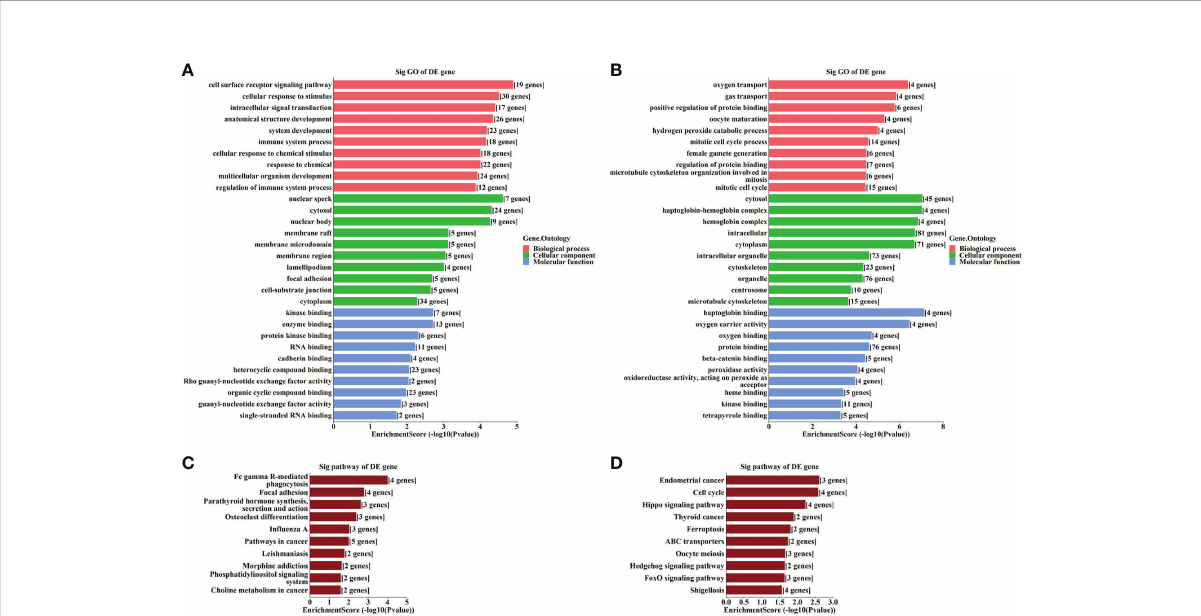
FIGURE 2 GO and KEGG analyses according to the host genes of the signi fi cantly altered circRNAs. (A) Top gene ontology (GO) terms with the host genes of the up-regulated circRNAs. (B) Top GO terms with the host genes of the down-regulated circRNAs. (C) Top Kyoto Encyclopedia of Genes and Genomes (KEGG) pathways with the host genes of the up-regulated circRNAs. (D) Top KEGG pathways with the host genes of the down- regulated